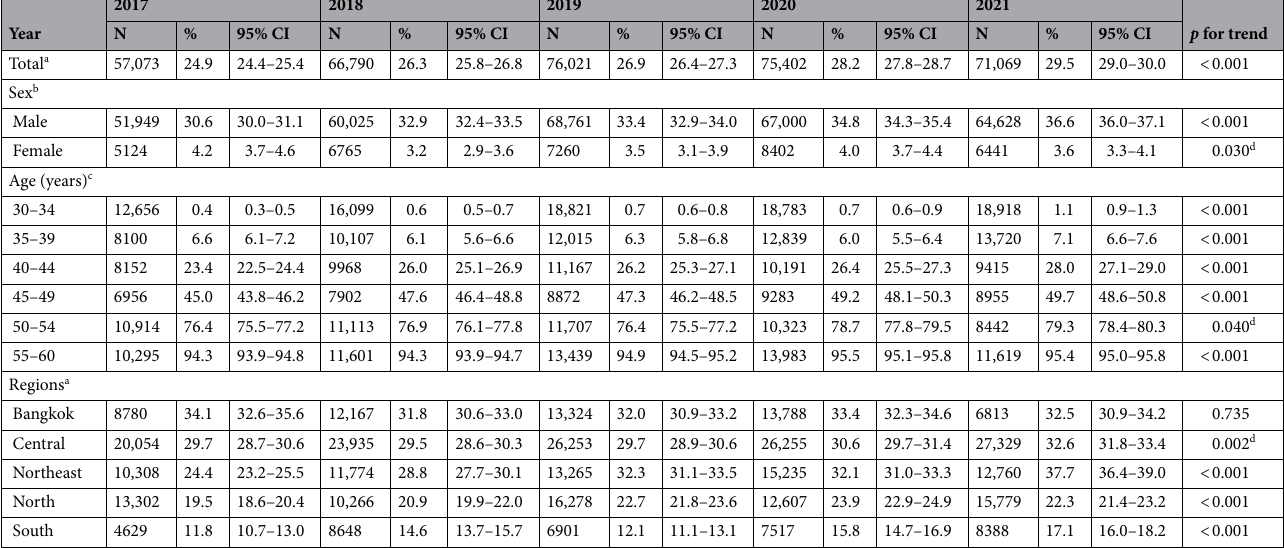
Table 3. Prevalence of intermediate-to-high of predicted 10-year risk for CVD among RTA personnel from 2017 to 2021. a Age- and sex adjusted prevalence using regression analyses. b Age-adjusted prevalence using regression analyses. c Sex-adjusted prevalence using regression analyses. d Nonlinear trend. CVD cardiovascular diseases, RTA Royal Thai Army, 95% CI 95% confidence